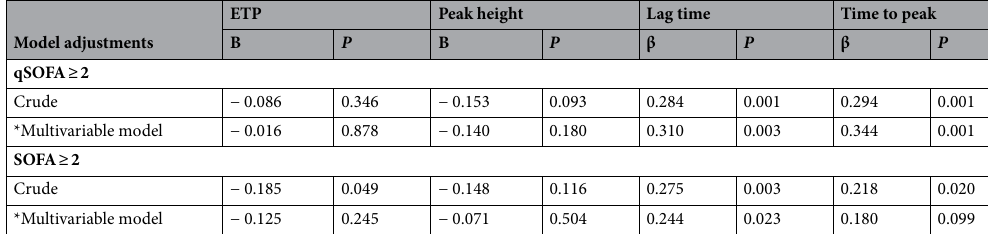
Table 3. Thrombin generation and qSOFA/SOFA scores, adjustment for confounders. β; the standardized regression coefficients, ETP (endogenous thrombin potential). *Adjusted for age, Sex, BMI, diabetes mellitus, ischemic heart disease, stroke/TIA, COPD, hypertension, heart failure, chronic kidney disease.